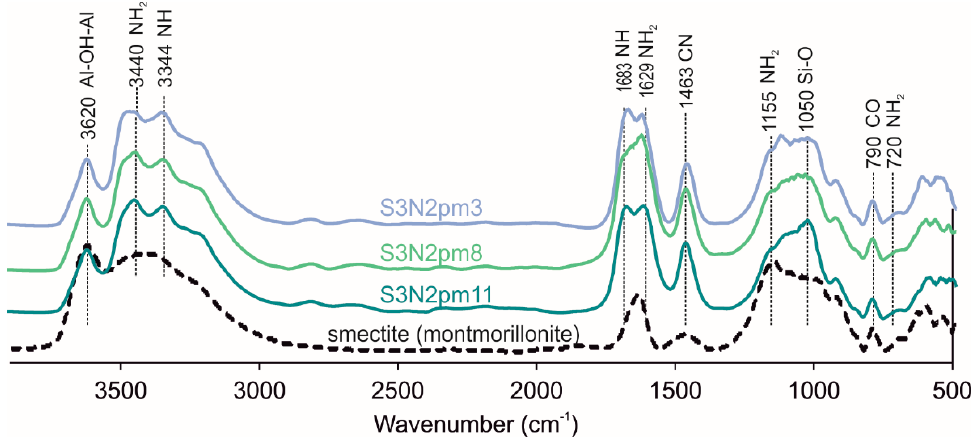
Figure 4. FTIR spectra of the S3N2pm composites. Note the systematic shifts in spectral characteristics of composites with increasing grinding time compared to smectite (montmorillonite).